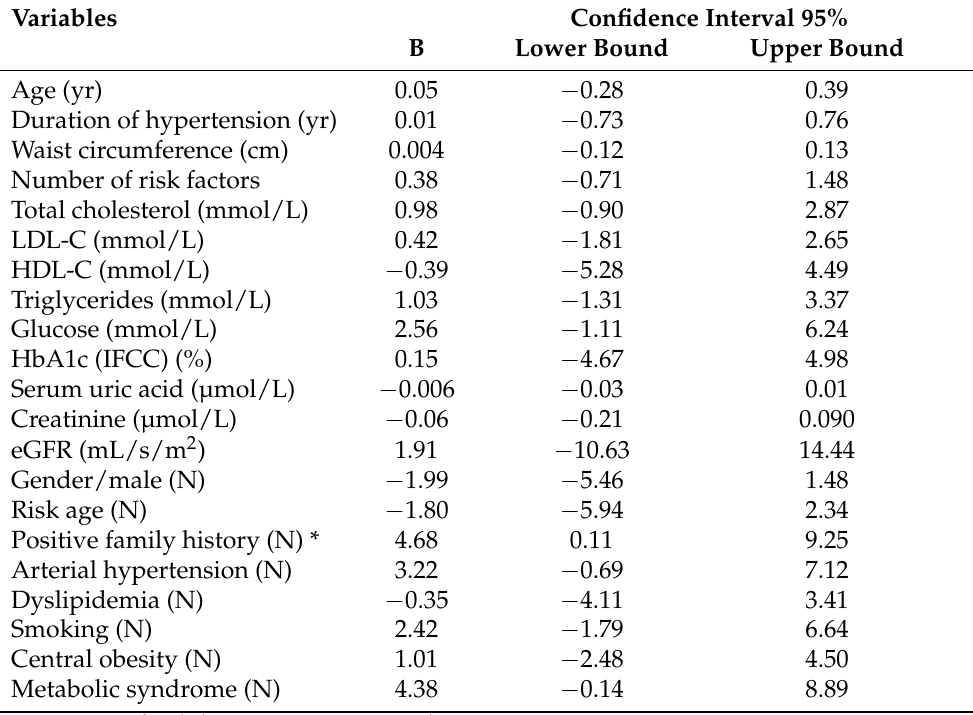
Table 6. Results of univariate linear regression analysis with testing possible effect on microalbu- minuria level by individual variables. Linear regression coefficient B and 95% confidence interval. Except for positive family history no statistically significant differences were found. Gender is not a significant